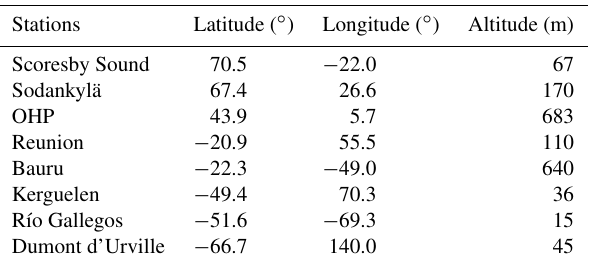
Table 3. List of the eight SAOZ stations used for the IASI total ozone column validation.